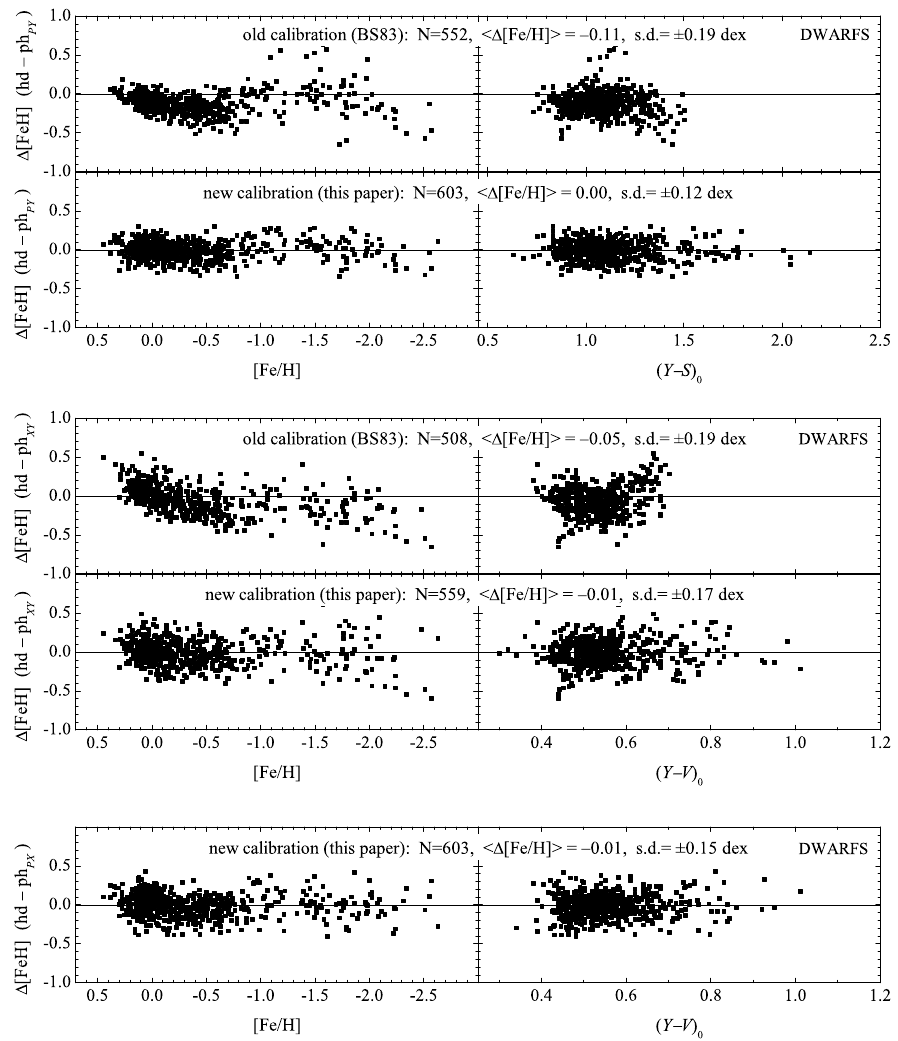
Fig. 8. Differences between [Fe/H] from high-dispersion spectroscopy and [Fe/H] from old (BS83) and new calibrations of Vilnius photometry for the same set of dwarf stars, shown as functions of [Fe/H] (left-had panels) and temperature-dependent color indices (right-hand panels). The number of stars compared, mean residuals and standard devi- ations are given on the top of each